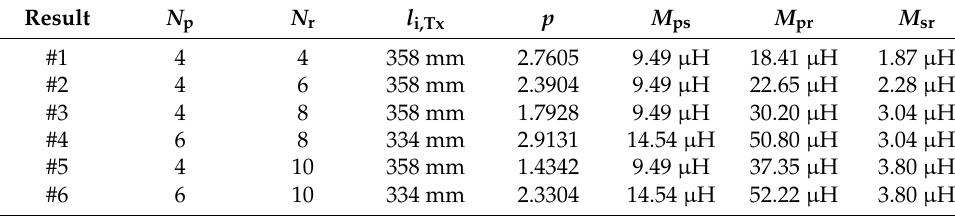
Table 1. Optimization results of the coils.